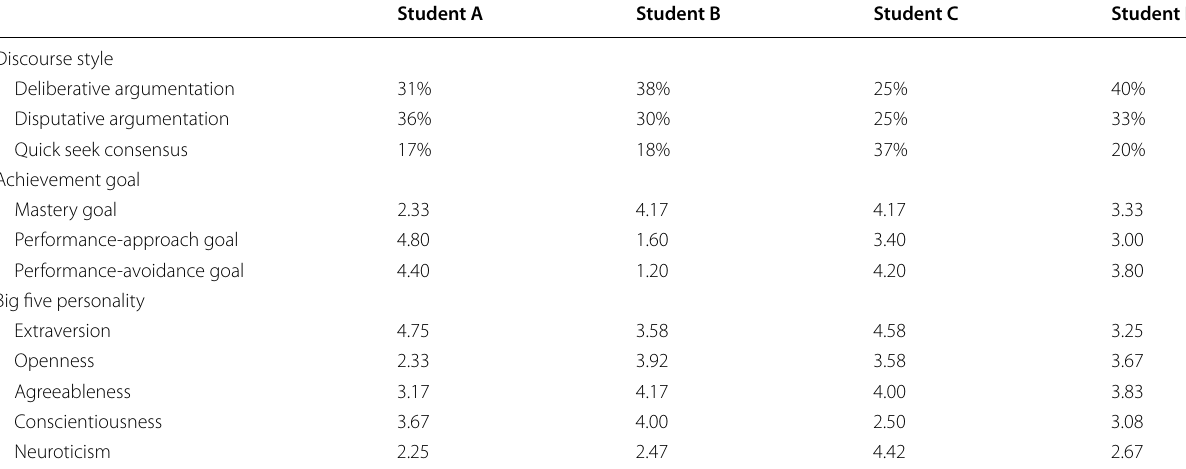
Table 2 discourse styles, achievement goals, and personality traits of four in a group Student